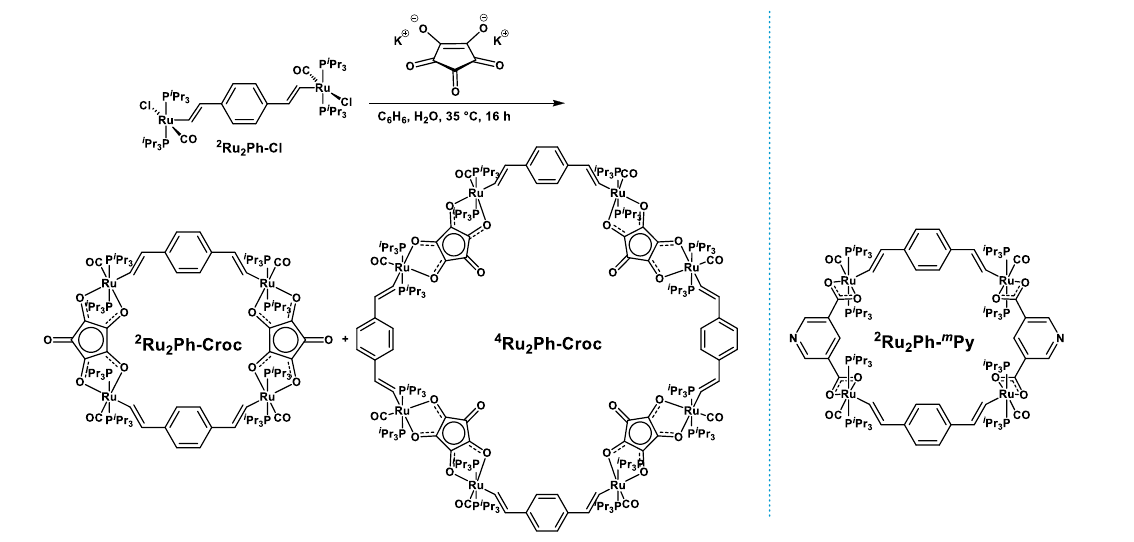
Scheme 1. ( left ): Synthesis and putative structures of the new macrocyclic complexes 2 Ru 2 Ph-Croc and 4 Ru 2 Ph-Croc ; ( right ): the isonicotinate-bridged tetraruthenium macrocycle 2 Ru 2 Ph- m Py .